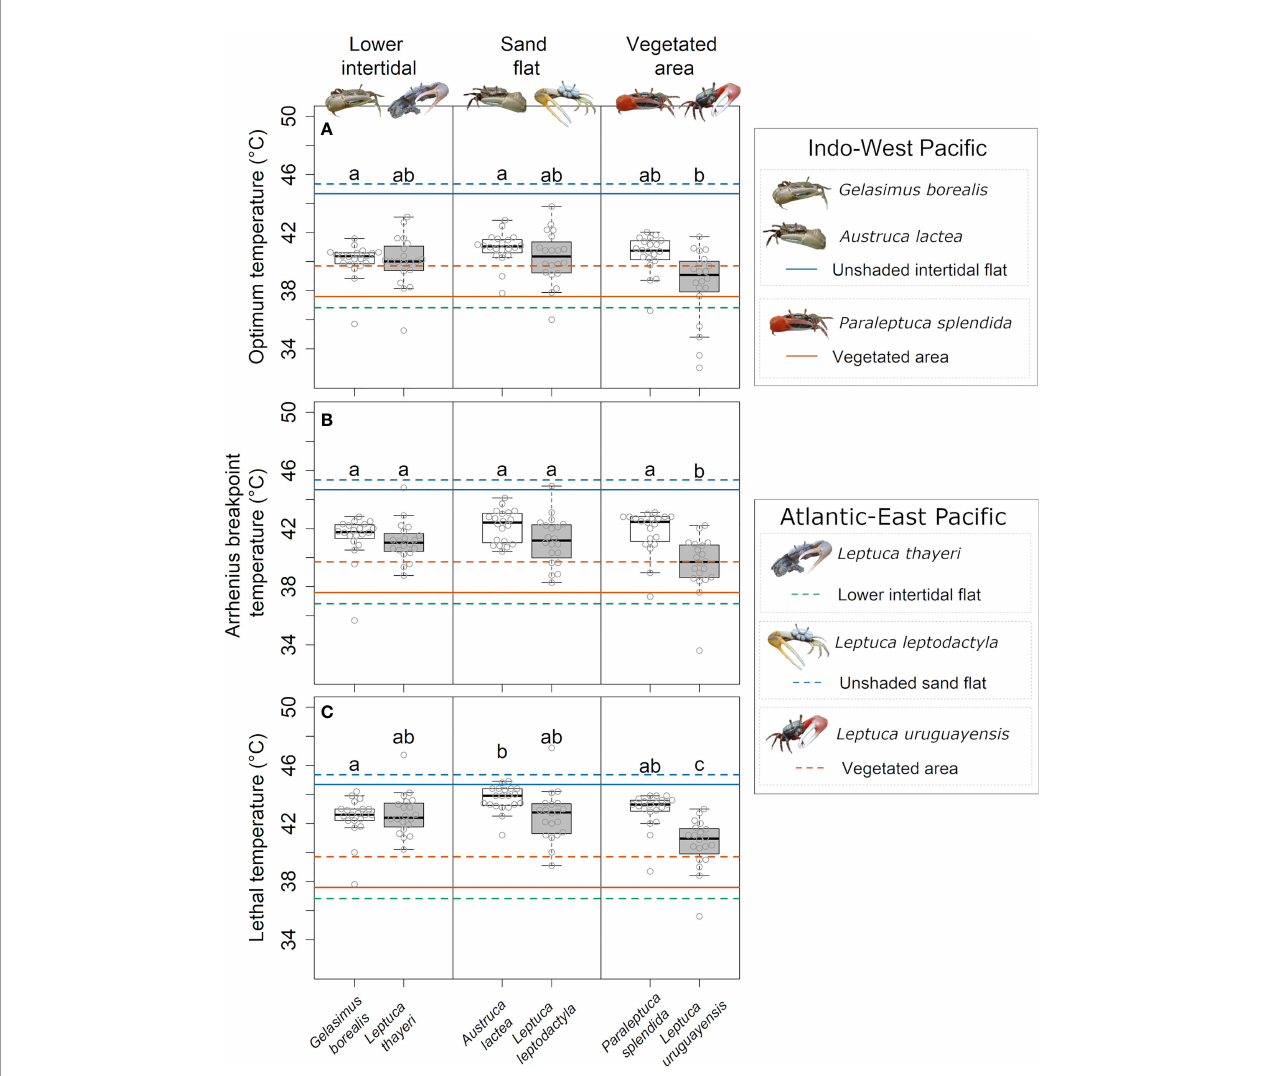
FIGURE 4 | Comparison of: (A) Optimum temperature (OPT); (B) Arrhenius Breakpoint Temperature (ABT); and (C) Lethal temperature (LT) among the model species across habitats. Boxplots show the median, 25th and 75th percentiles, and whiskers are 1.5 times the spread beyond the hinge. White boxes represent Hong Kong species, grey boxes represent Brazilian ones. Circles are the raw data points. Dashed lines and continuous lines represent the maximum temperatures experienced by the model species at the collection sites in Brazil and Hong Kong, respectively. Different letters represent signi fi cant differences among species (PERMANOVA pairwise, p <